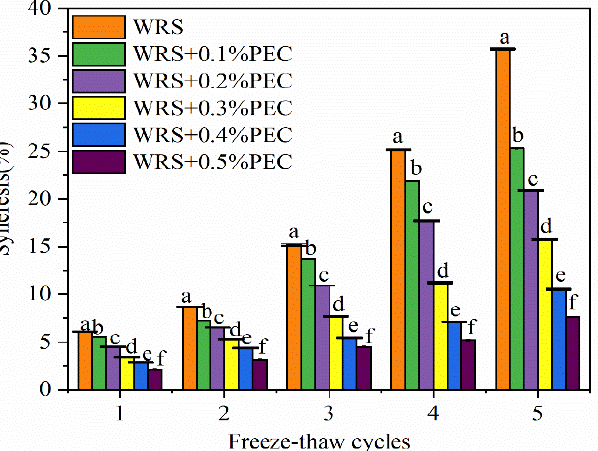
Figure 5. Effect of PEC on the freeze-thaw stability of the WRS and the WRS–PEC mixtures. Means with different small letter superscripts are significantly different at p < 0.05.